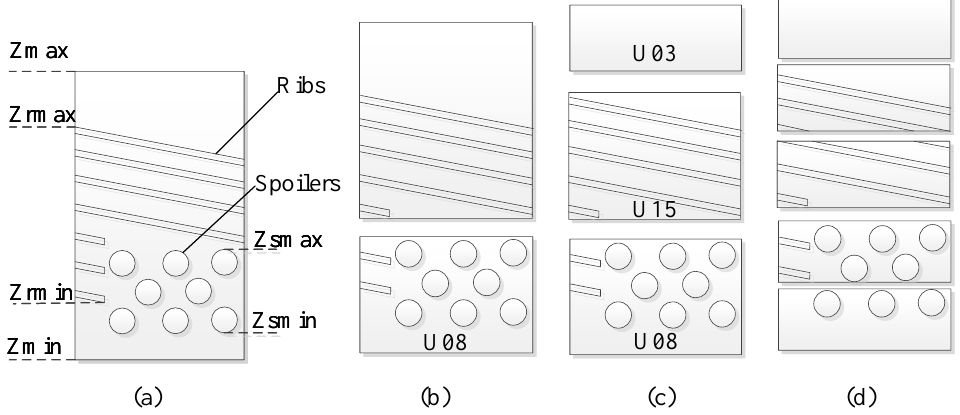
Figure 20. Schematic diagram of diameter division process: ( a ) longitudinal flow channel, ( b ) U08 unit separation, ( c ) U15 unit separation, and ( d ) internal division of similar